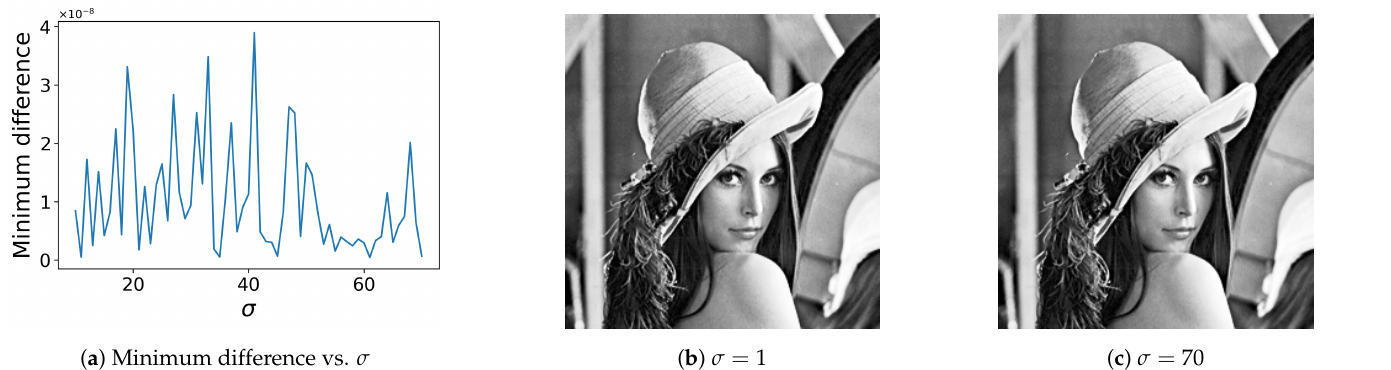
Figure 11. Insensitivity to parameter σ : ( a ) the minimum difference in the sorted values of F GF as a function of σ . The positive values mean that there are no pixels with the same pixel value in Gaussian-filtered image F G F , from which we have a strict ordering; ( b ) histogram equalization with σ = 1; ( c ) histogram equalization with σ = 70.